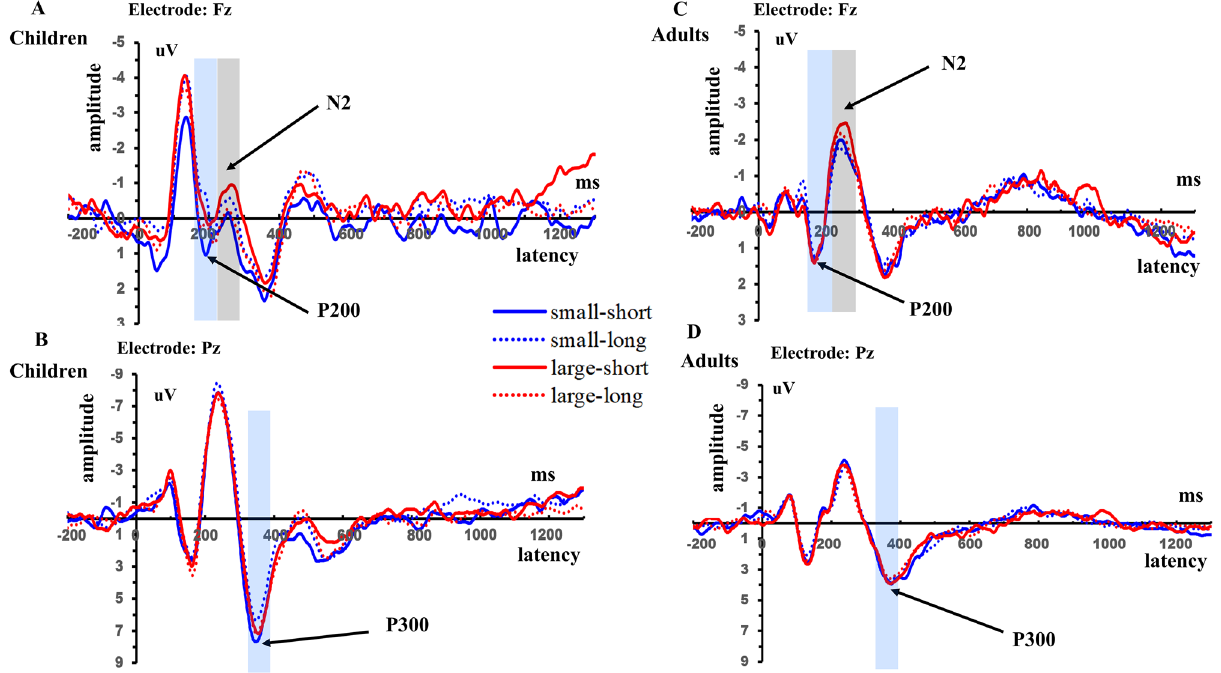
Figure 3. The grand-averaged N2 and P2 ERP waveforms at electrode Fz ( A ) and P3 waveforms at electrode Pz ( B ) in children. ( C ) and ( D ) shows the N2 and P2 waveforms at Fz and P3 waveforms at Pz in adults. The picture was created by Microsoft Excel 2016 MSO (16.0.13628.20234) 64 bits (https:// www. micro soft. com/ zh- cn/ micro soft- 365/ excel) and Microsoft PowerPoint 2016 MSO (16.0.13628.20234) 64 bits (https:// www. micro soft. com/ zh- cn/ micro soft- 365/ power For N2 amplitudes, the interaction of reward amount, age and gender was marginally significant, F (1, 102) = 3.21, p = 0.08, ƞ 2 = 0.03. It was further found that in the small amount conditions for males, the N2 ampli- tudes of children were smaller than those of adults (mean children = − 0.22, mean adults = − 1.90, p = 0.012), while no differences were found between the amplitudes of children and adults in the small amount conditions for females or in the large amount conditions for males and females (small amount, female: mean children = −0.71, mean adults = −1.09, p = 0.59; large amount, female: mean children = −0.51, mean adults = −1.72, p = 0.15; large amount, male: mean children = −0.80, mean adults = −2.04, p = 0.10).